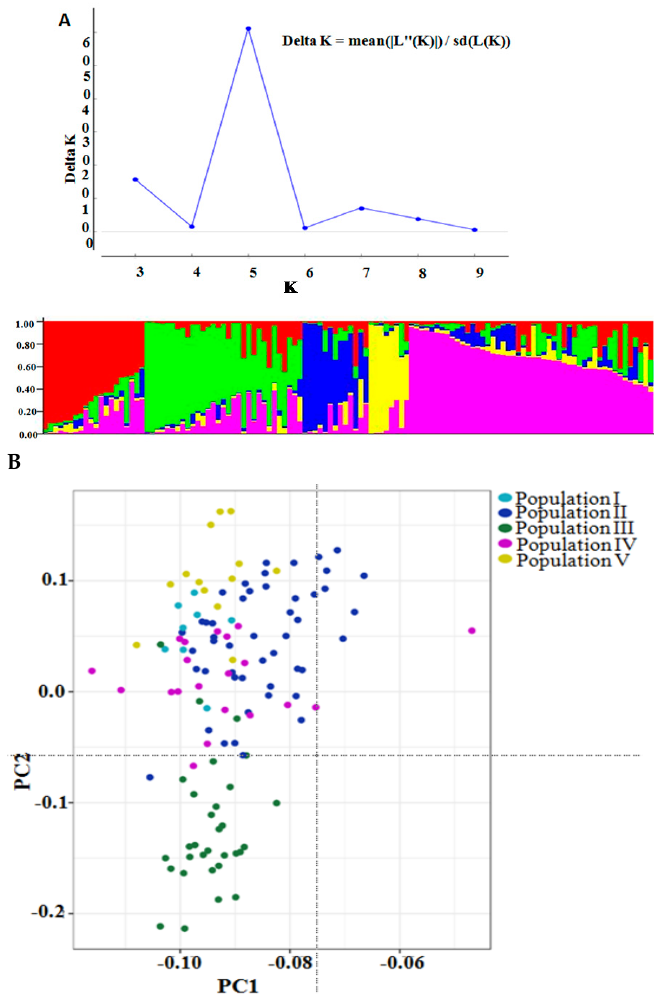
Figure 4. ( A ) Delta K plot displaying best peak at K = 5 to determine the ideal number of groups in 120 diverse mungbean population. ( B ) Population structure plot of 120 mungbean genotypes (k = 5, each color represents one sub population). ( C ) Principal component analysis of mungbean association mapping panel (genotypes with different colors represents the five sub populations plus admixture in the population.